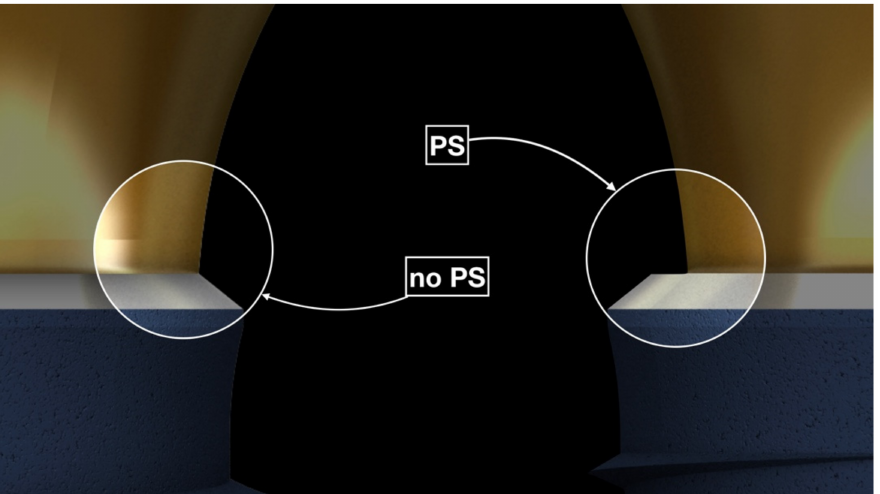
Figure 1. Two implant designs: with platform-switching (PS) technology and without. It can be noticed that the switched abutment is narrower than the implant